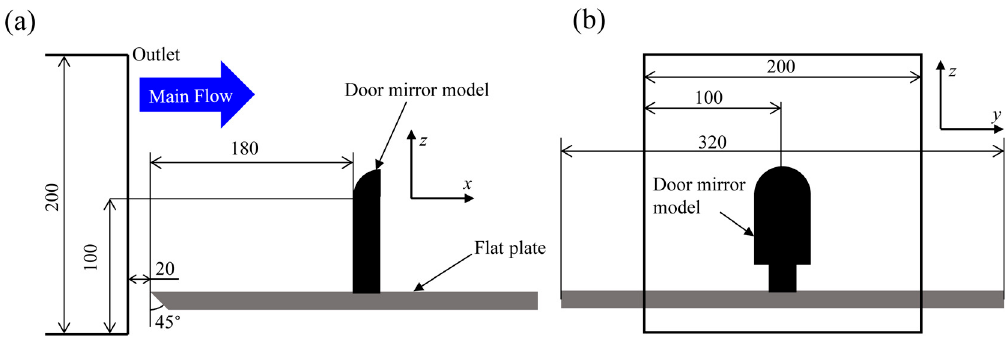
Figure 3. Location of the door mirror model at ( a ) x – z cross section and ( b ) y – z cross section.